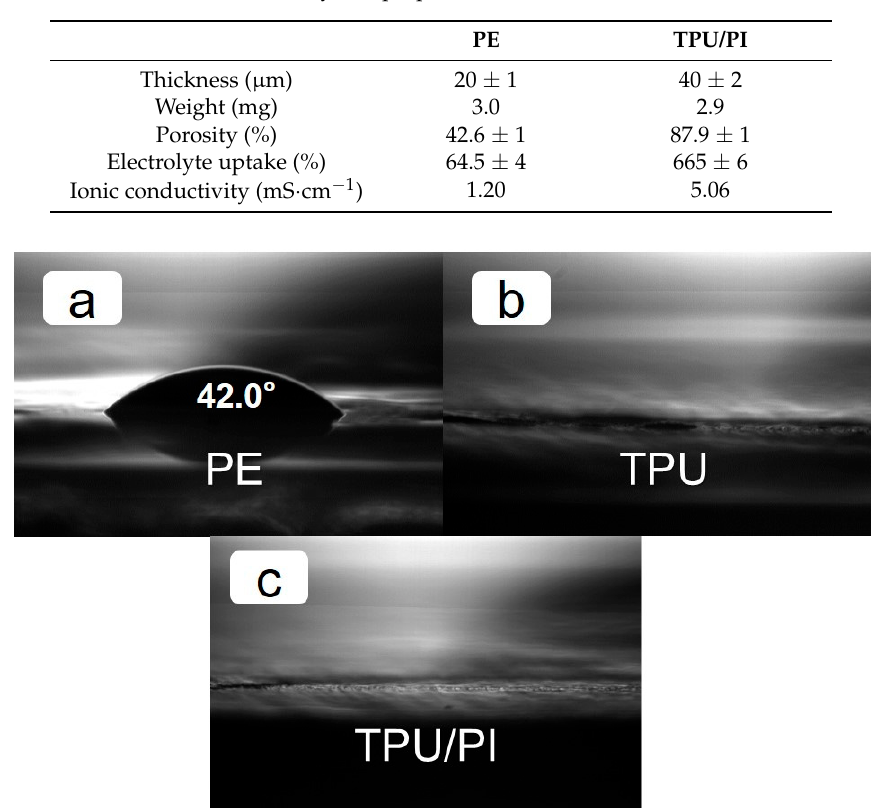
Figure 5. Contact angles of ( a ) PE, ( b ) TPU membrane, ( c ) TPU/PI membrane.